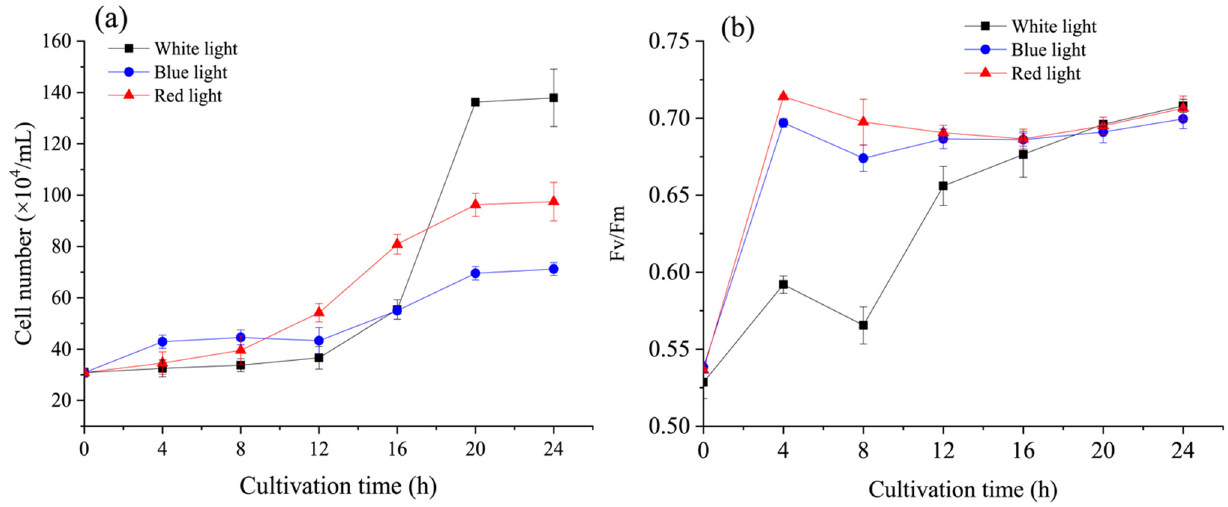
Figure 3. Effect of light wavelength on ( a ) cell number and ( b ) F v /F m of C. reinhardtii under N ‐ recovery. Data are presented in the form of mean ± the standard deviation ( n = 3).